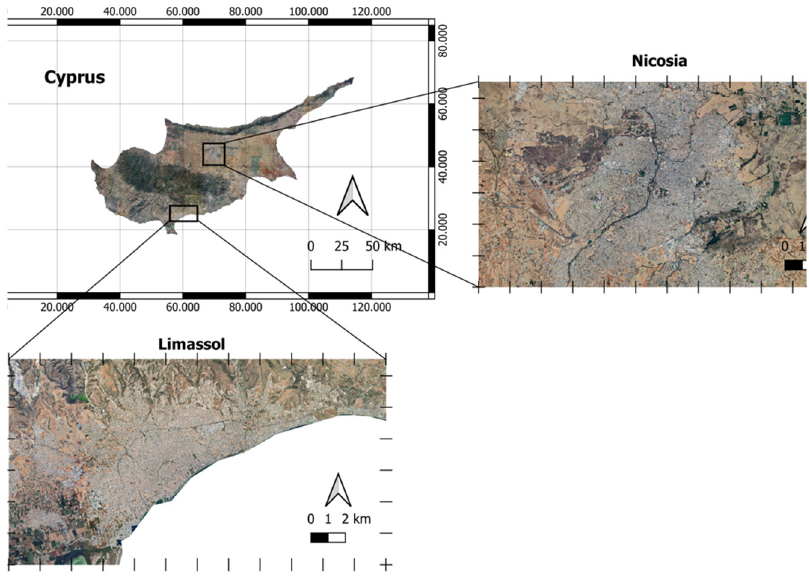
Figure 1. Cyprus and the Areas of Interest (satellite images).